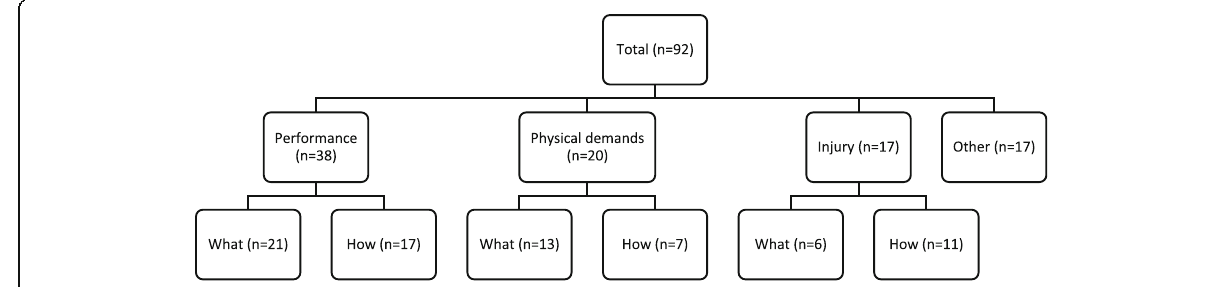
Fig. 3 Categories of video analysis studies; n = the number of